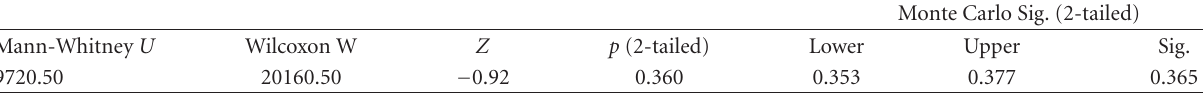
Table 2: Mann-Whitney U test comparing PA versus CBCT for lesion sizes across 6 observers.